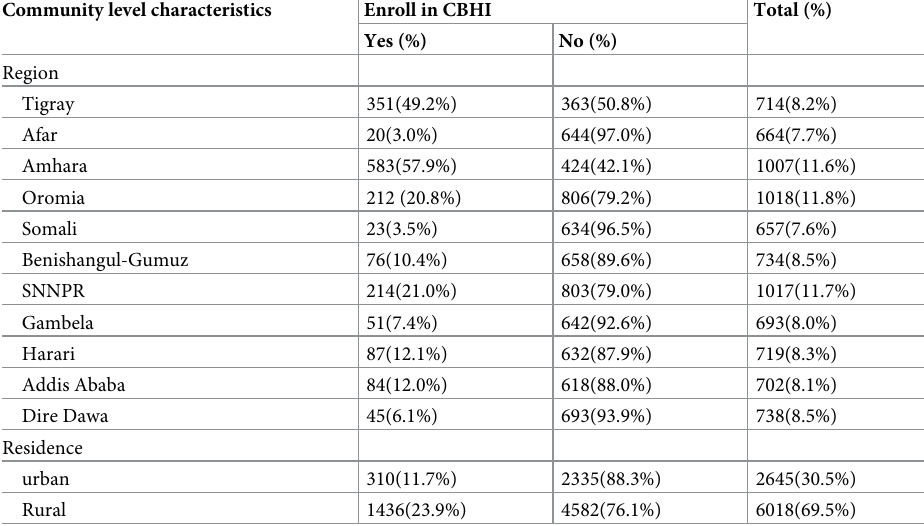
Table 2. Characteristics of community level factors of CBHI enrollment, Mini-EDHS 2019. Community level